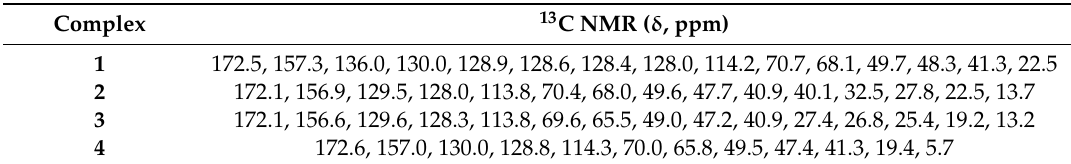
Table 4. 13 C NMR data (125 MHz) for complexes 1–4